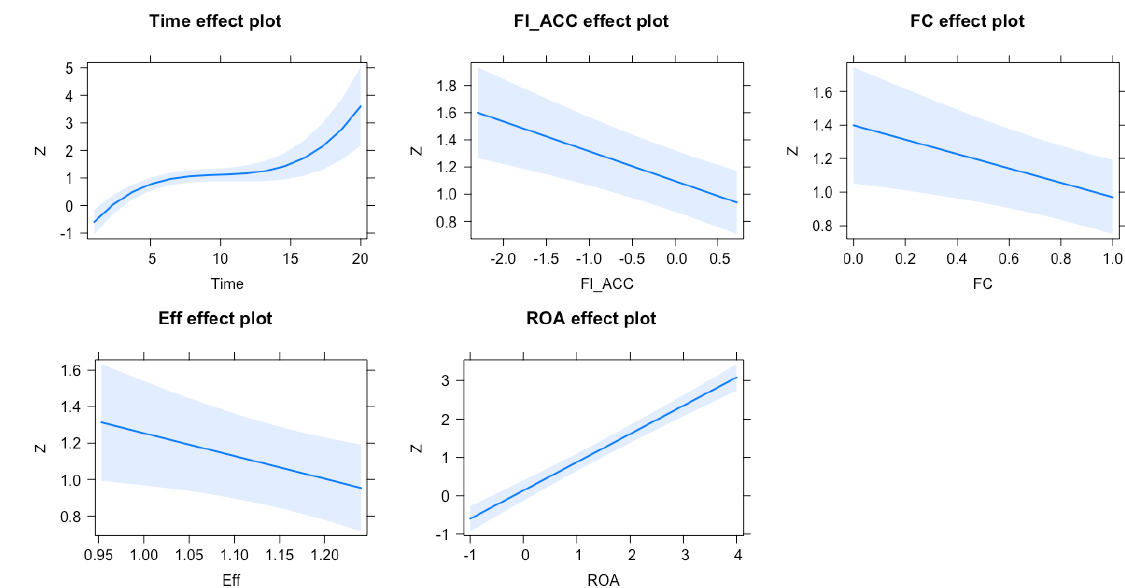
Figure 6. Significant factor effect plots for Islamic banks.